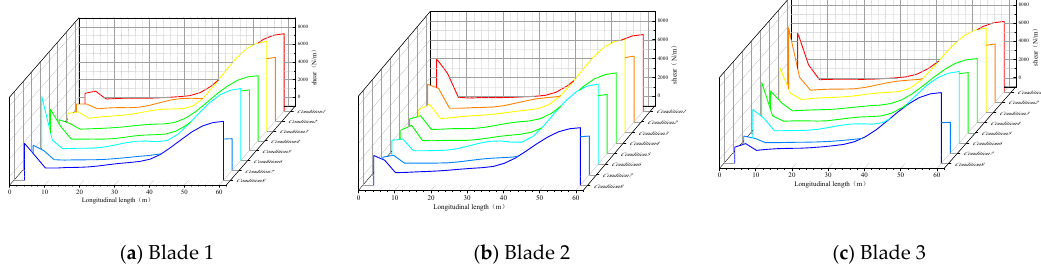
Figure 29. Distributions of RMS of shearing force on blades under different conditions.